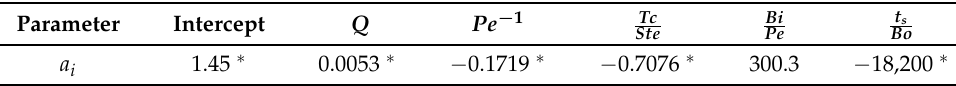
Table 3. First attempt of the regression analysis to estimate the coefficients, a i , using the linear least-squares approach. Asterisk ( ∗ ) indicates the statistical significance of the coefficient using a t-test with a 95% confidence interval. Other statistics: R 2 = 0.65, Adjusted R 2 = 0.61, F-statistic = 20.12, P(F) = 0.0. Condition number = 8.11 × 10 7